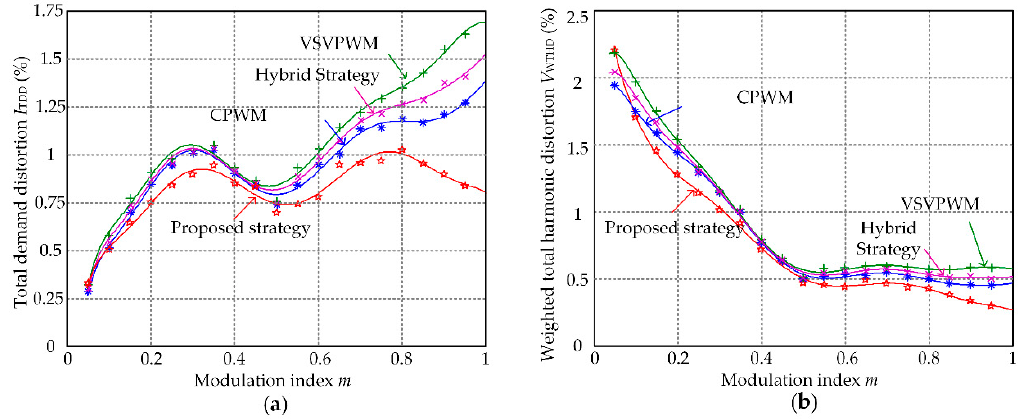
Figure 15. The dependence of I TDD and V WTHD on m for CPWM with neutral-point balancing, VSVPWM, hybrid strategy and the proposed strategy: ( a ) I TDD ; ( b ) V WTHD .